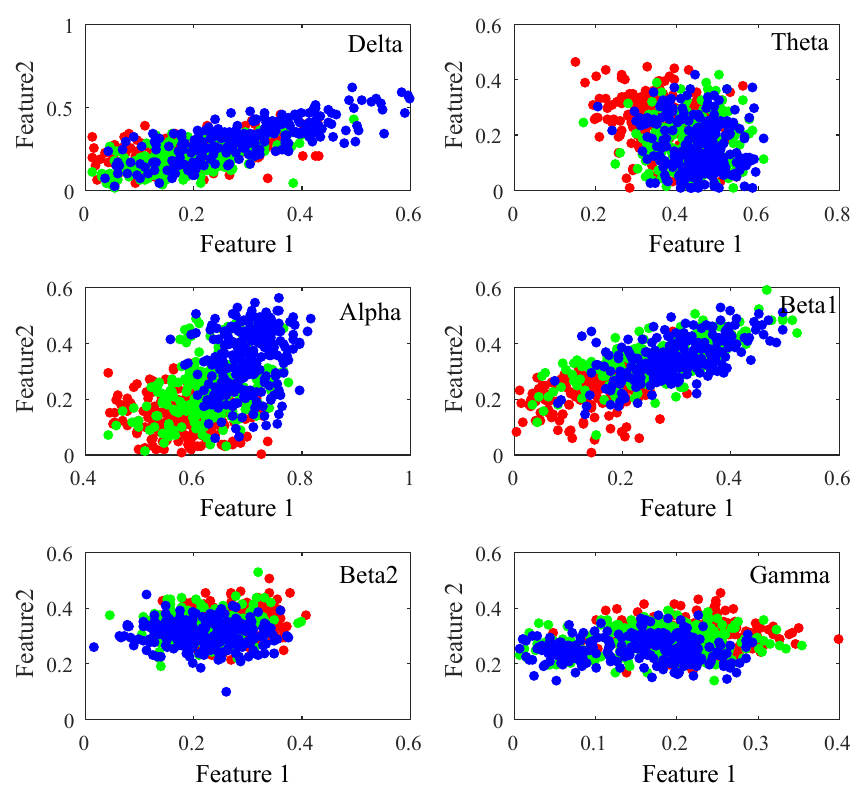
Figure 8. 2-D figure of PLV feature visualization for each frequency band. The Feature 1 and Feature 2 are the selected features with the first two largest r 2 values, respectively. The dots represent different sleep stages (red:REM, green:N2,